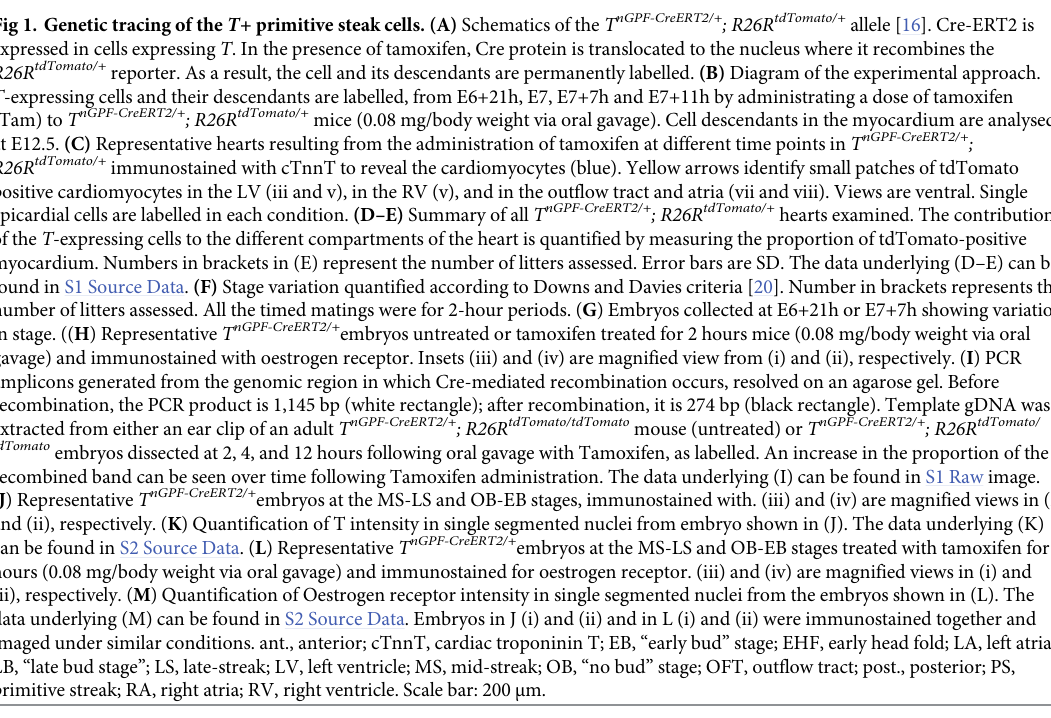
hearts analysed; Fig 1Ci, 1D, and 1E). The contribution of tdTomato-positive cardiomyocytes